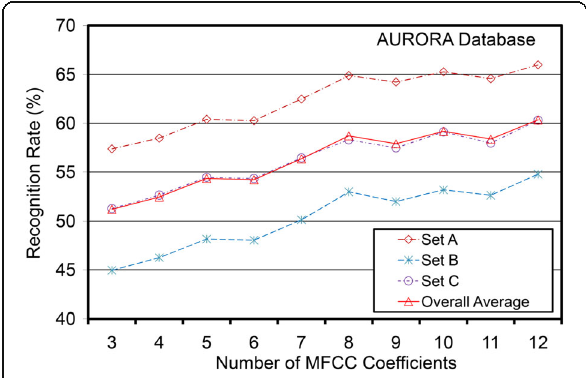
Fig. 8 Variation of recognition rate with Fisher-Markov selector for different number of MFCC on the Aurora 2